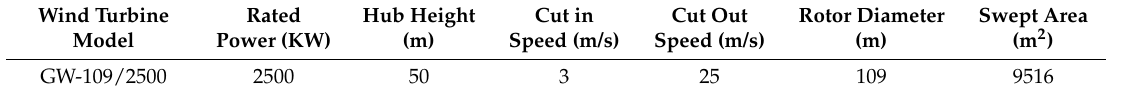
Table 4. Selected wind turbine specifications